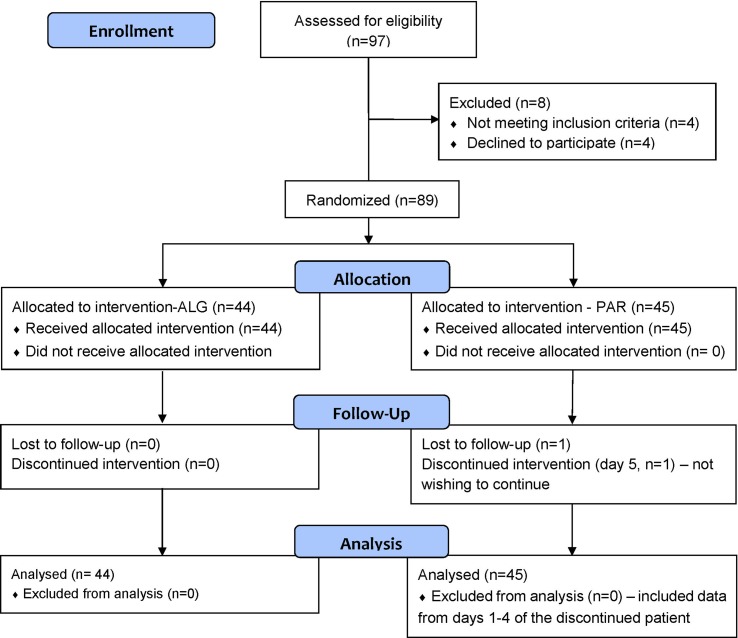
Flow diagram of the progress of the patients through the phases of the trial, according to CONSORT 2010.